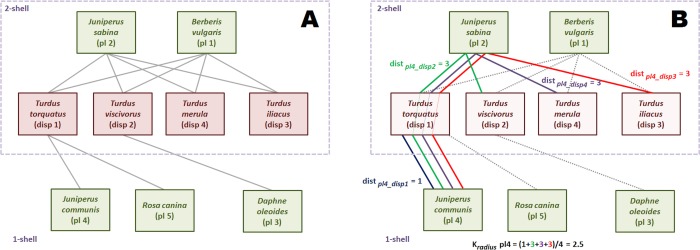
Computation of the k-magnitudes.Seed disperser network in Santa Bárbara, Sierra de Baza (Spain) (Jordano, 1993). (A) Decomposed network. (B) Computing \documentclass[12pt]{minimal}
\usepackage{amsmath}
\usepackage{wasysym}
\usepackage{amsfonts}
\usepackage{amssymb}
\usepackage{amsbsy}
\usepackage{upgreek}
\usepackage{mathrsfs}
\setlength{\oddsidemargin}{-69pt}
\begin{document}
}{}${k}_{radius}^{A}(4)$\end{document}kradiusA4.